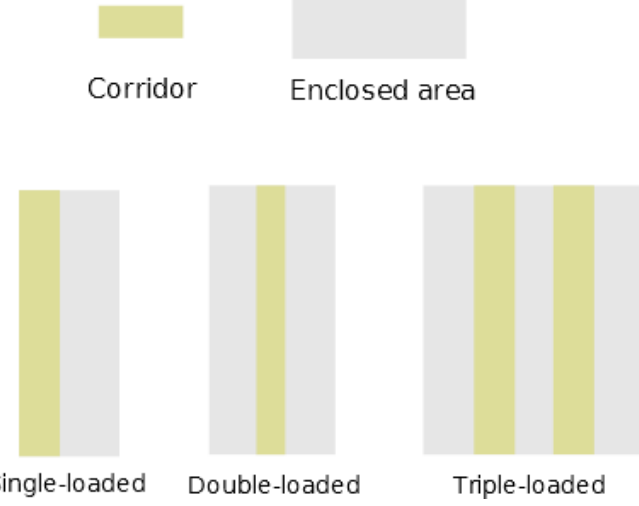
Figure 1. Three typical plans of research buildings.